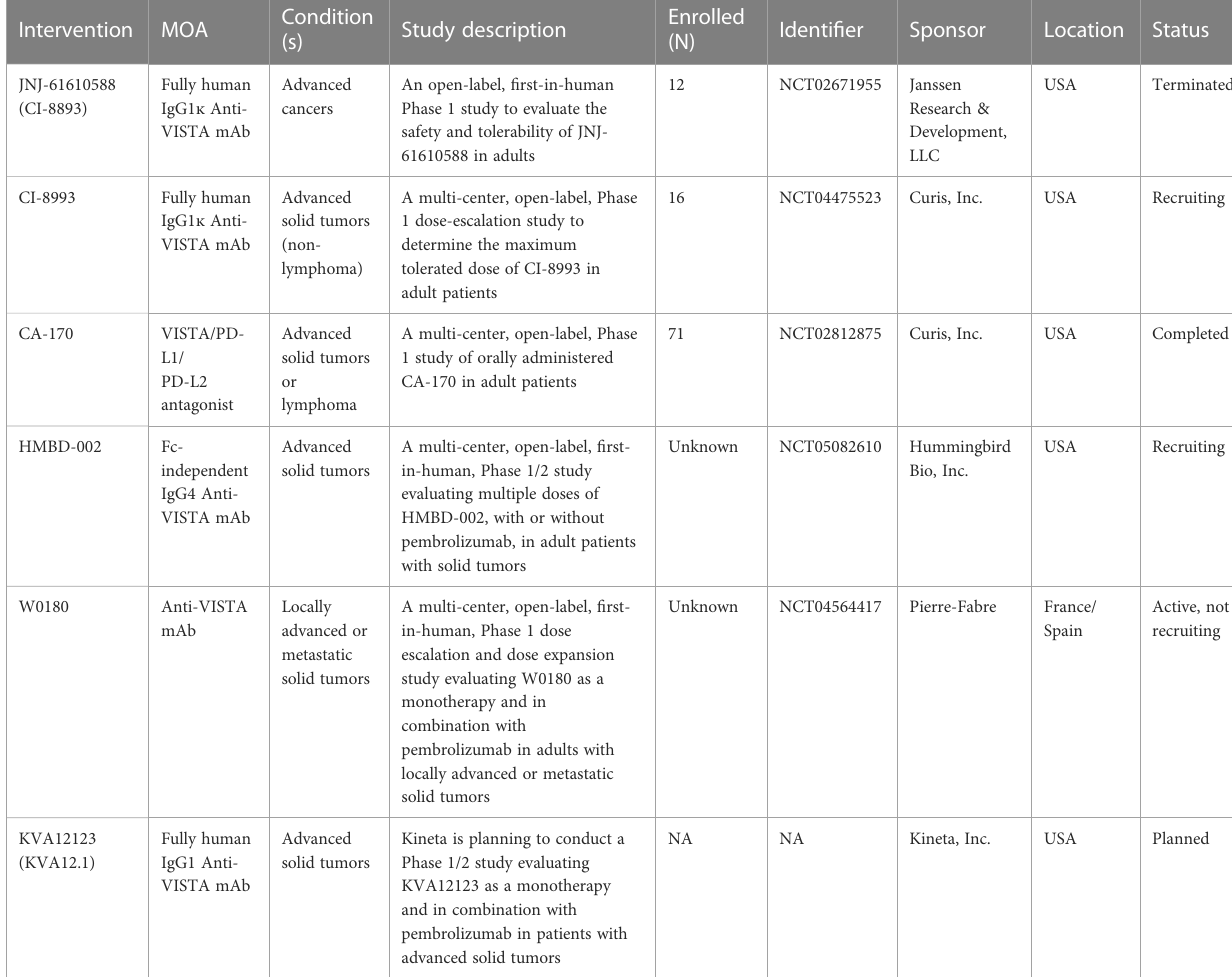
TABLE 1 Clinical studies of agents targeting the VISTA